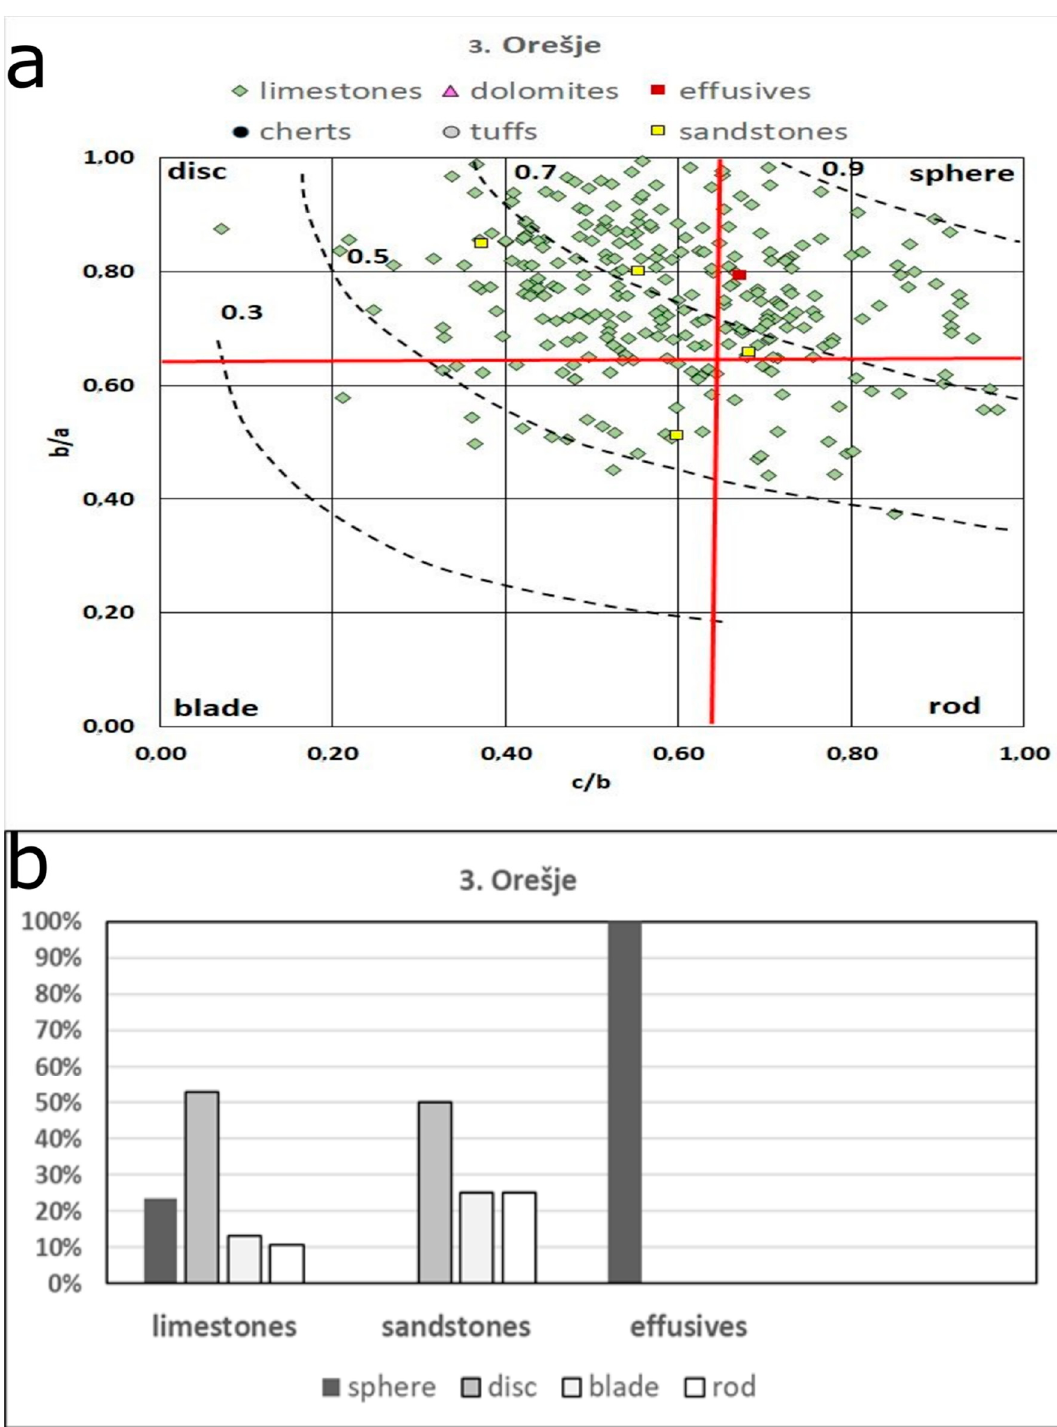
Figure 9. Pebble shapes of main lithotypes in Orešje: ( a ) Zingg diagram; ( b ) histograms.